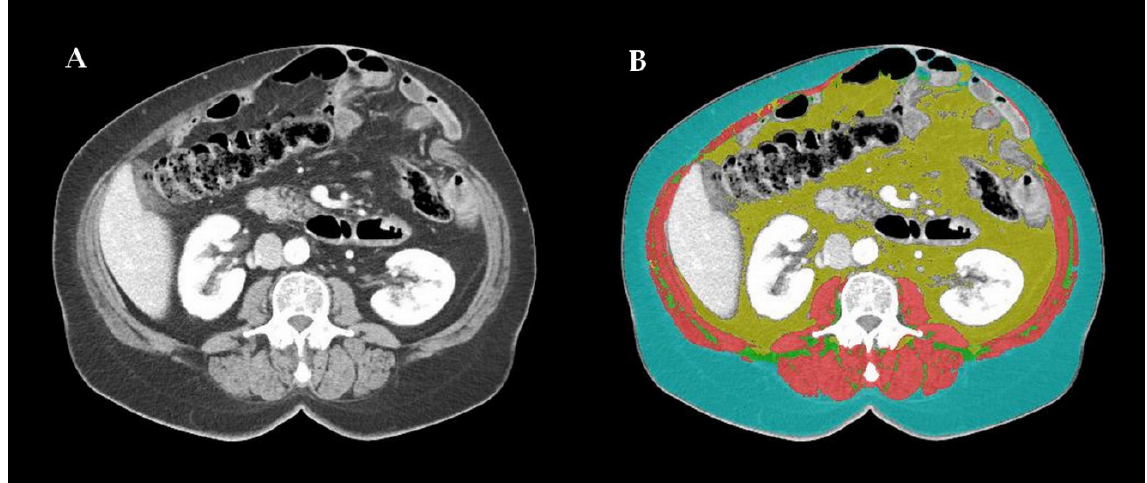
Figure 1. ( A ) Example of contrast-enhanced computed tomography scan of the third lumbar vertebra (L3) region in the venous phase (contains psoas, paraspinal and abdominal wall muscles); ( B ) image processed by Data Analysis Facilitation Suite ver. 2.0.5 by Voronoi Health Analytics, Vancouver, Canada with the Automatic Body composition Analyzer using Computed tomography image Segmentation module provided by Voronoi Health Analytics, Canada (2020); non-optimal segmentations were re-edited using open-source software 3D Slicer ver. 4.11 by 3D Slicer, Boston, Massachusetts, USA; skeletal muscles (pink) are separated from intra-abdominal fat (yellow) and subcutaneous fatty tissue (blue).